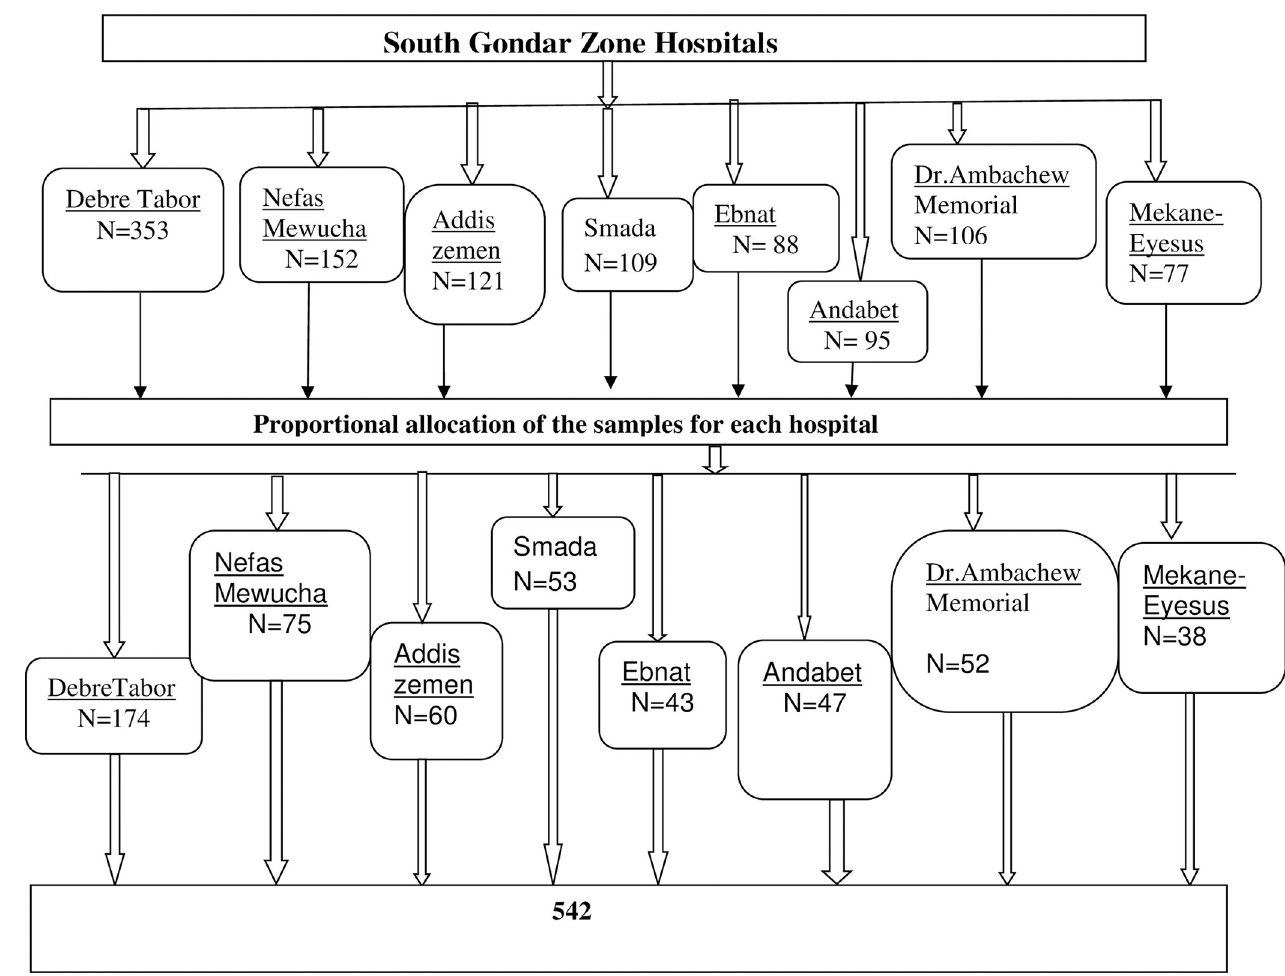
Fig 1. Sampling procedure for the cognitive adverse effect of epilepsy and its predictors attending South Gondar hospitals Amhara Ethiopia 2020/2021.